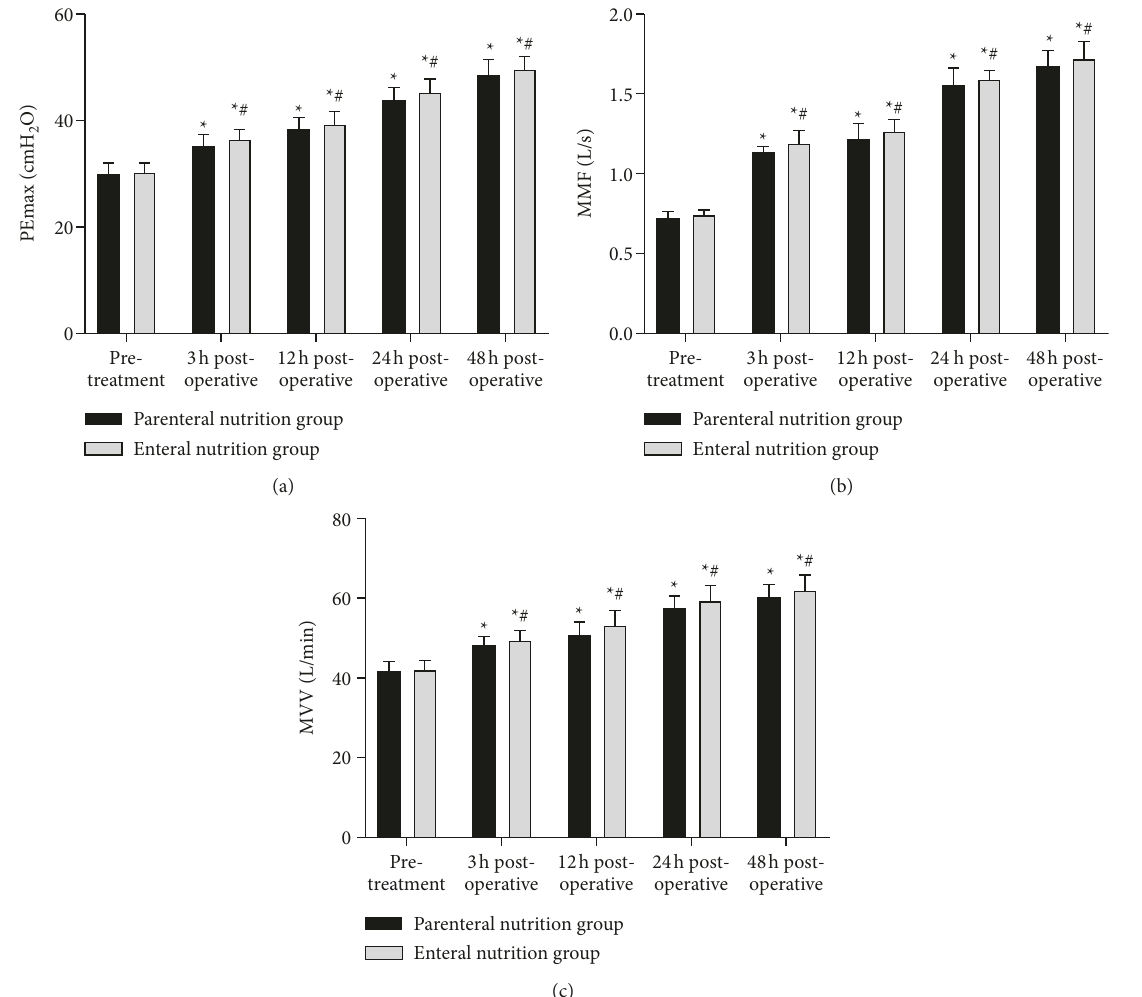
Figure 2: Comparison of pulmonary function indexes between two groups. (a) Pemax level. (b) MMF levels. (c) MVV levels. with the same group before treatment, # comparison with the parenteral nutrition group at the same time point. There is a statistical difference.